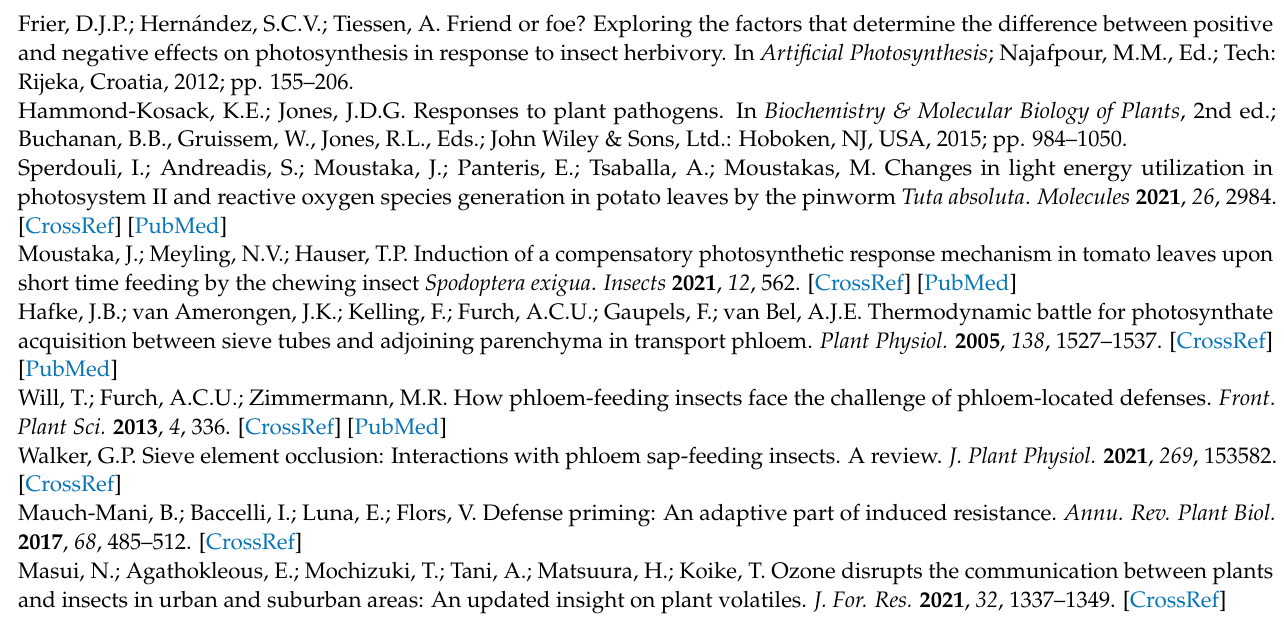
Figure S5: Histogram of all data points of the fraction of open PSII reaction centres (qp) per time point. Figure S6: Typical colour-coded images of Φ PSII , Φ NPQ , and Φ NO , before insect feeding and immediately after 20 min